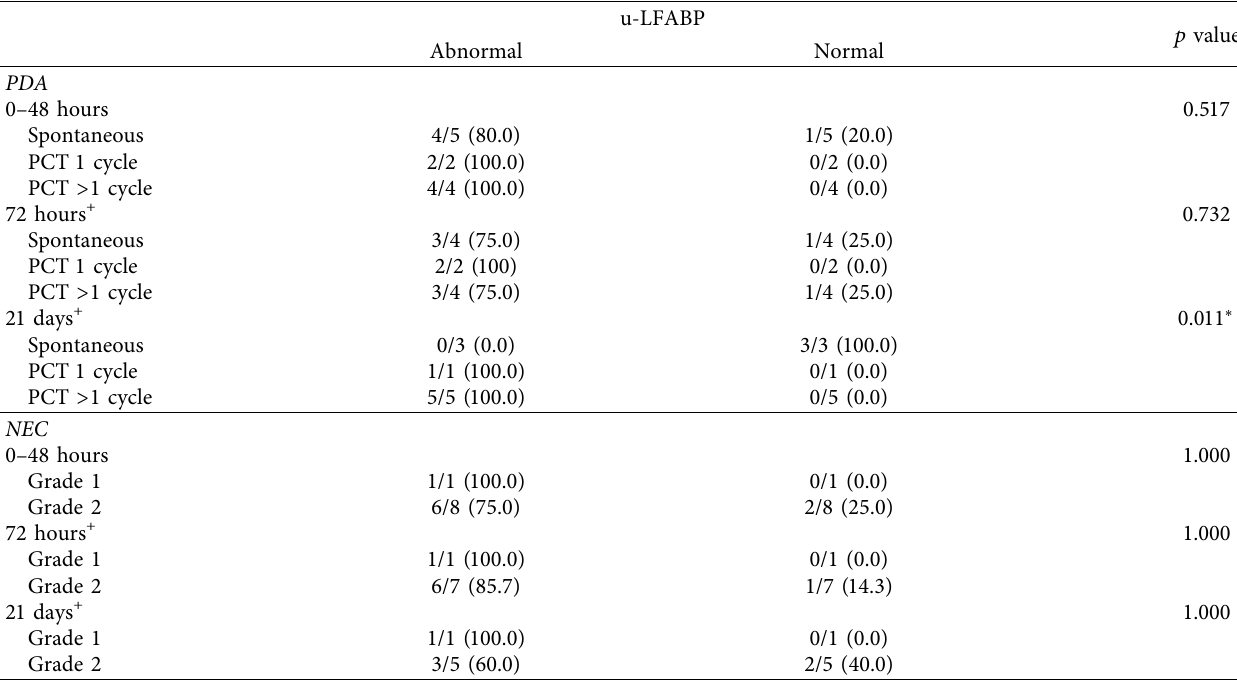
Table 3: u-LFABP levels based on disease severity.